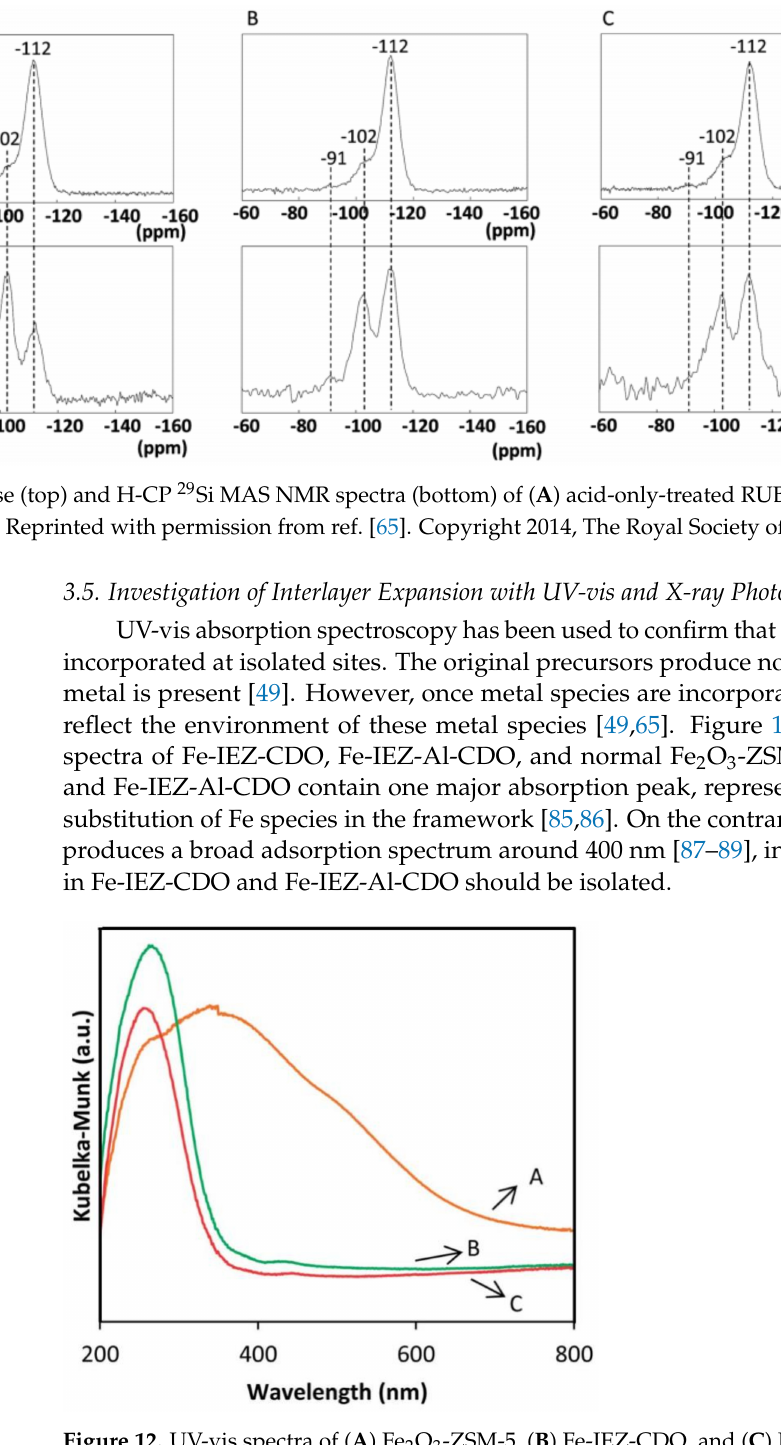
Figure 12. UV-vis spectra of ( A ) Fe 2 O 3 -ZSM-5, ( B ) Fe-IEZ-CDO, and ( C ) Fe-IEZ-Al-CDO. Reprinted with permission from ref. [65]. Copyright 2014, The Royal Society of